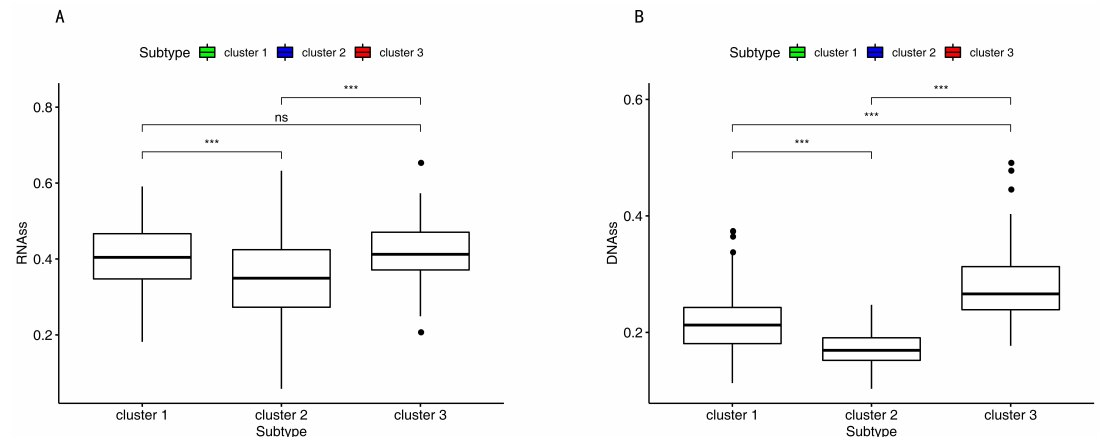
Figure 7. RNA stemness score and DNA stemness score. ( A , B ) RNAss and DNAss among the three subgroups. Three asterisks indicate a p -value less than 0.001. Ns indicates no significance.